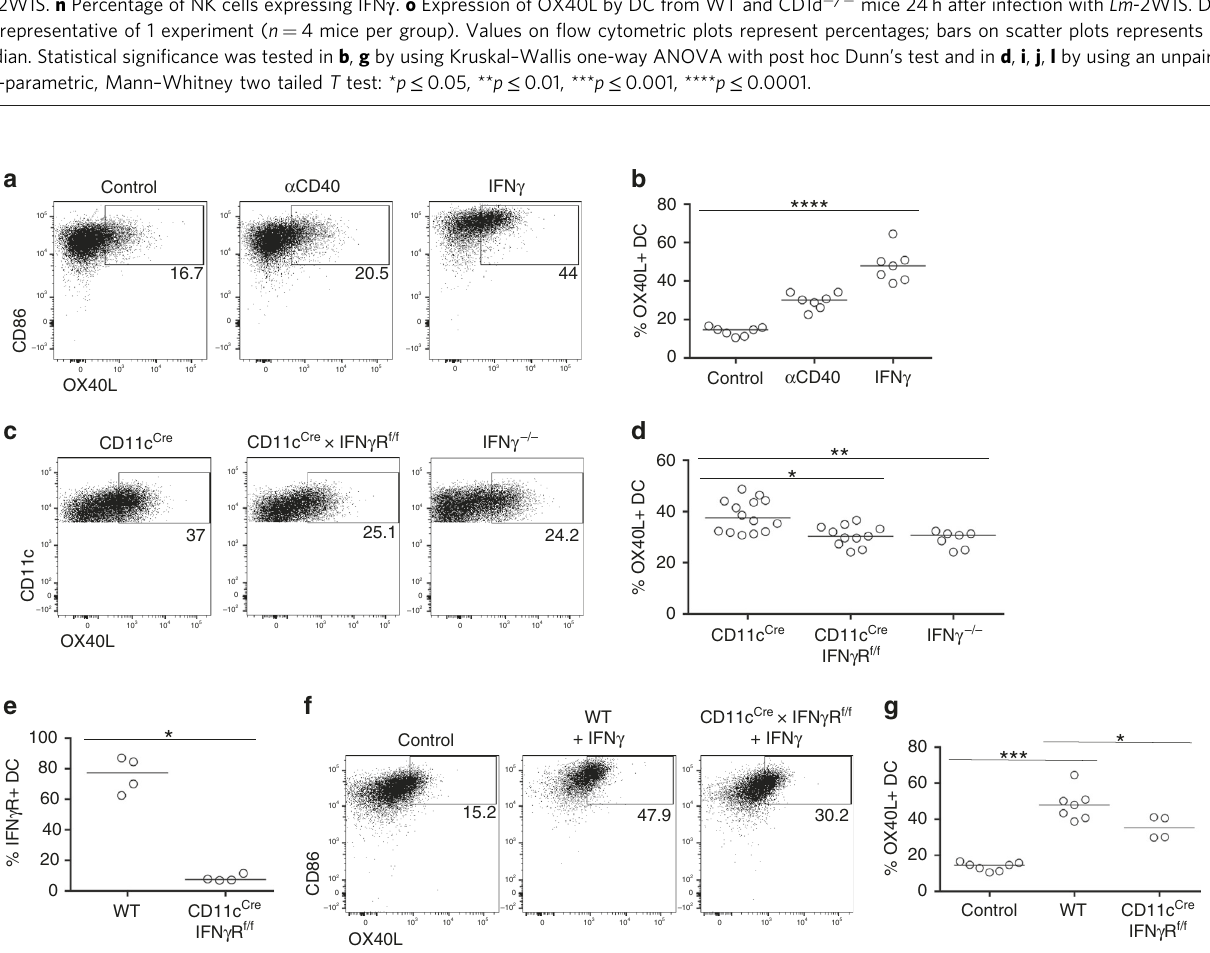
Fig. 4 OX40L is upregulated on DCs in response to IL-12-mediated production of IFN γ by NK cells. Splenocytes were isolated from mice at different times post infection with Lm -2W1S. a Expression of OX40L by DC (lin − (CD3, B220, CD49b), CD11c + , MHCII + , CD86 + , SIRP α + ) from uninfected mice and mice infected with Lm -2W1S 24, 48 and 72 h previously. b Proportion of DC-expressing OX40L at different times post infection with Lm -2W1S, versus uninfected and PGK cre × OX40L f/f controls. Data are representative of 2 independent experiments ( n = 5 PGK cre × OX40L f/f mice, n = 7 UN WT mice, n = 9 WT mice at 24 h post Lm -2W1S, n = 7 WT mice at 48 h post Lm -2W1S, n = 6 WT mice at 72 h post Lm -2W1S infection). Great × Smart17A mice were used to assess IFN γ production at 24 h post infection. c Representative fl ow cytometric plots showing the expression of IFN γ by NK cells. d Percentage of NK cells expressing IFN γ (eYFP). e Representative fl ow cytometric plots showing the expression of IFN γ by different immune cells. f Percentage of total